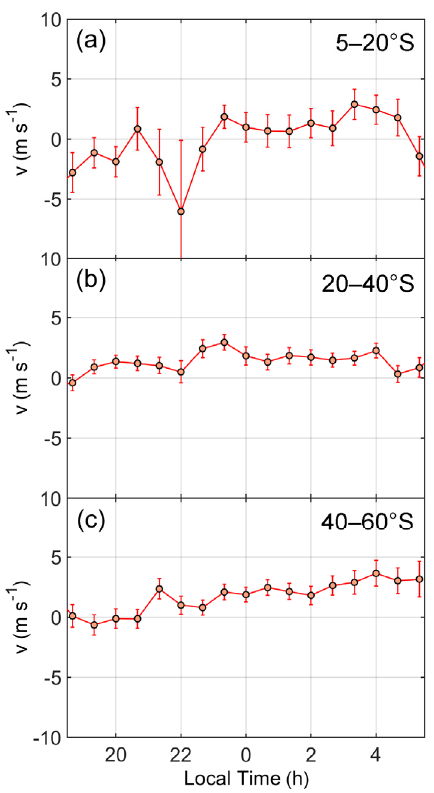
Figure 7. Local time profile of the meridional wind speed constrained in latitude bins of 5–20° S ( a ), 20–40° S ( b ) and 40–60° S ( c ). Error bars show standard error for a 99% confidence interval.